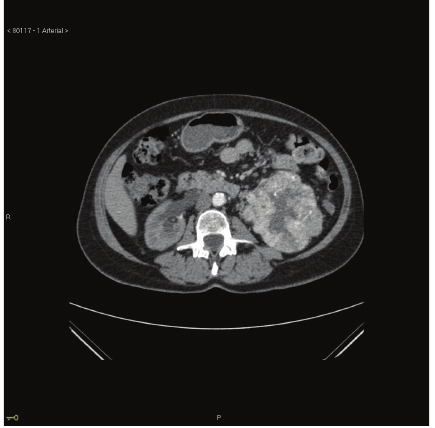
Figure 2: Portal venous phase CT (oblique sagittal MPR) showing an enhancing 9 mm soft tissue lesion (arrows) obstructing the lower moiety ureter right kidney.